Question: Does the figure show an increasing or a decreasing trend?
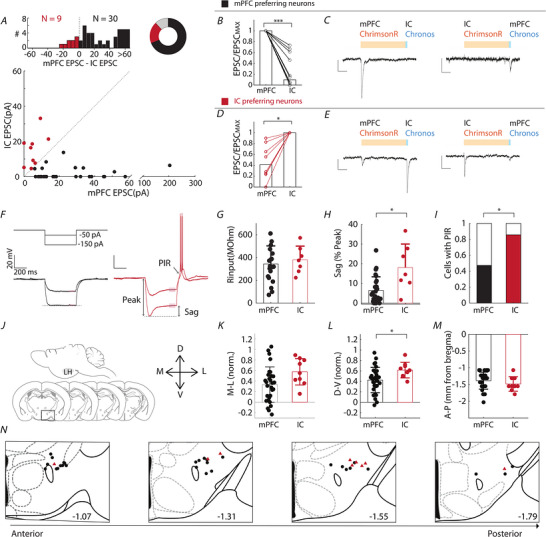
Answer: increasing